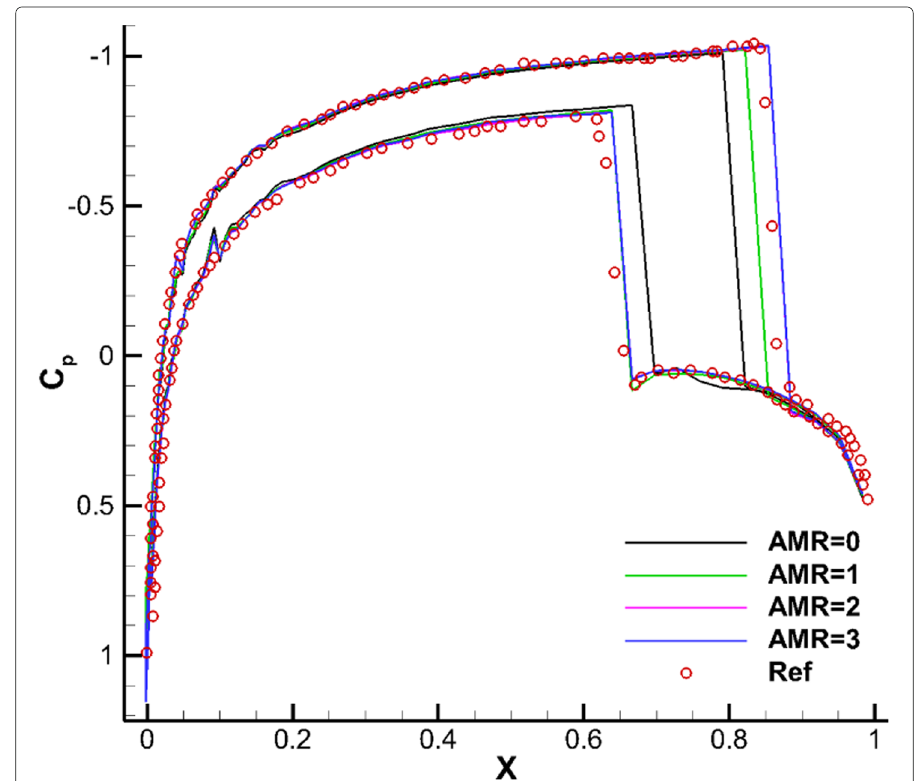
Fig. 14 Simulated surface pressure coefficient distributions obtained with different levels of refinement for the inviscid flow over a single NACA0012